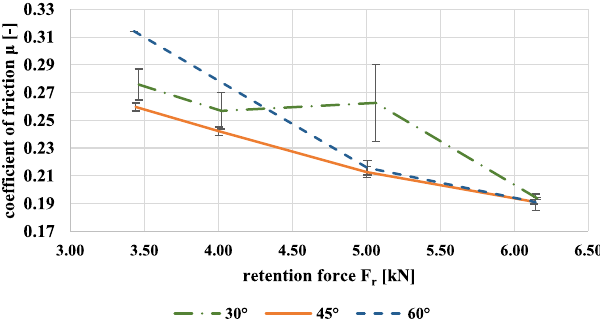
Fig. 16. Coef fi cient of friction for a radius insert of 5mm radius using CO 2 as lubricant substitute at different injection angles a (30 ° , 45 ° , 60 °